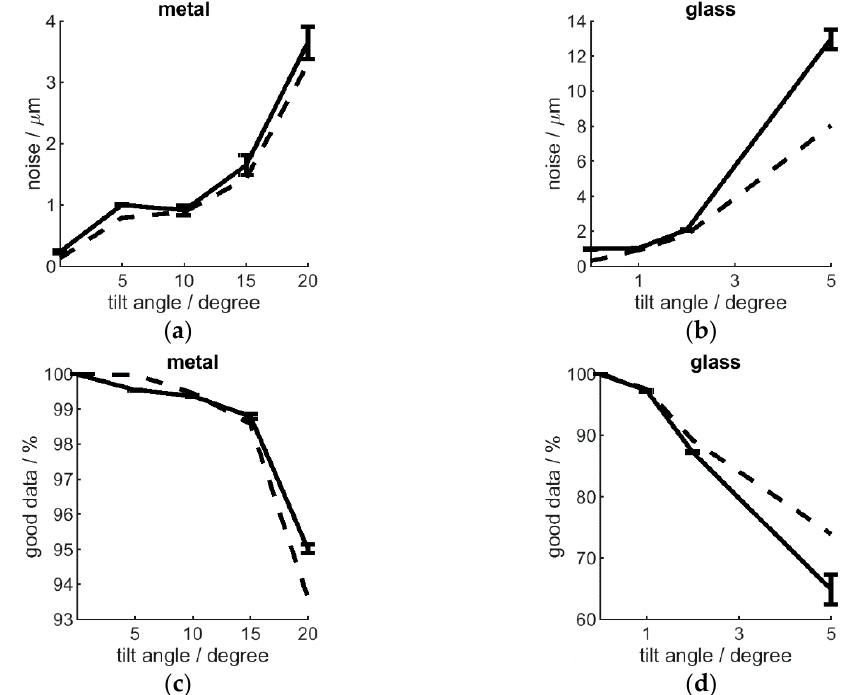
Figure 9. The effect of tilted sensor-to-sample orientation, showing noise ( a , b ) and data quality ( c , d ) for a metal ( a , c ) and a glass ( b , d ) surface, standard deviation is shown by the error bars. R5 optics and high Z resolution used.